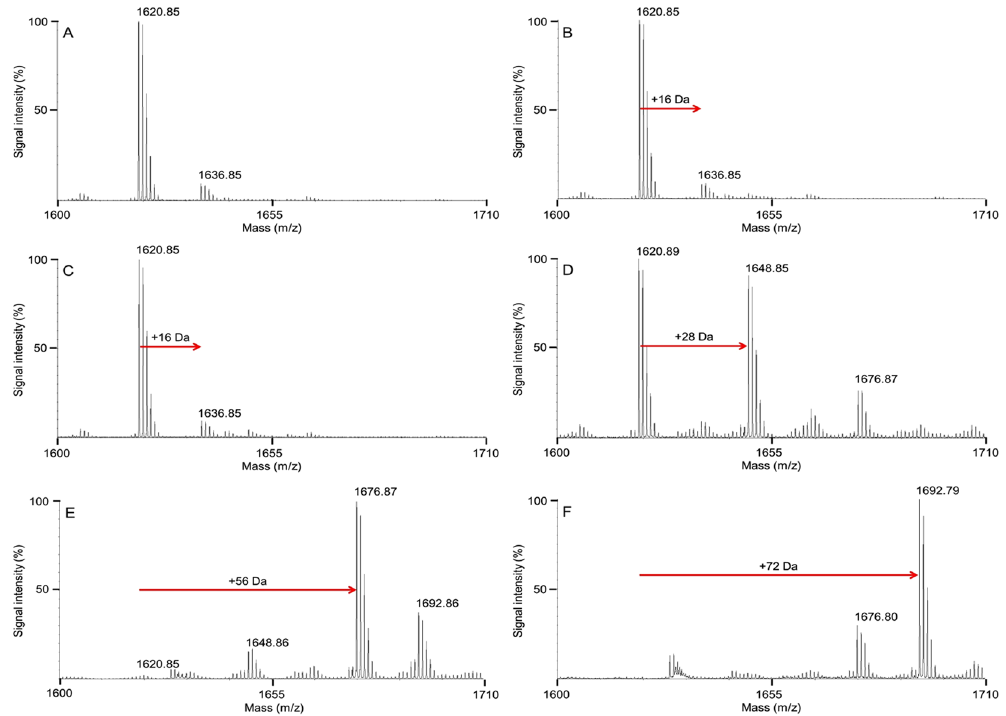
Figure 3. Mass spectra of the test peptide irradiated with 360,000 laser pulses at wavelength 386 nm in ACN:water (98:2% v/v). ( A ) Control (non-irradiated) peptide, ( B ) laser intensity 1.91 × 10 8 W cm − 2 (average pulse energy 9.5 μ J; fluence 28.7 μ J cm − 2 ), ( C ) intensity 3.66 × 10 8 W cm − 2 (average pulse energy 18.2 μ J; fluence 54.9 μ J cm − 2 ), ( D ) intensity 1.14 × 10 9 W cm − 2 (average pulse energy 56.8 μ J; fluence 171.3 μ J cm − 2 ); ( E ) intensity 2.58 × 10 9 W cm − 2 (average pulse energy 128.5 μ J; fluence 387.1 μ J cm − 2 ), and ( F ) intensity 2.49 × 10 11 W cm − 2 (average pulse energy 293.9 μ J; fluence 37.4 mJ cm − 2 ). Modifications, including change in mass, are indicated with red